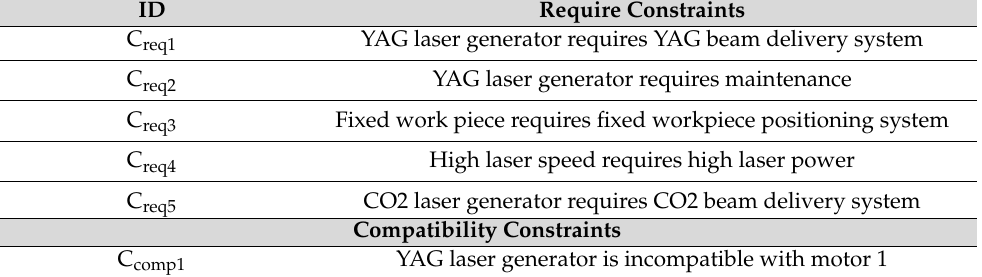
Table 8. Examples of require and compatibility